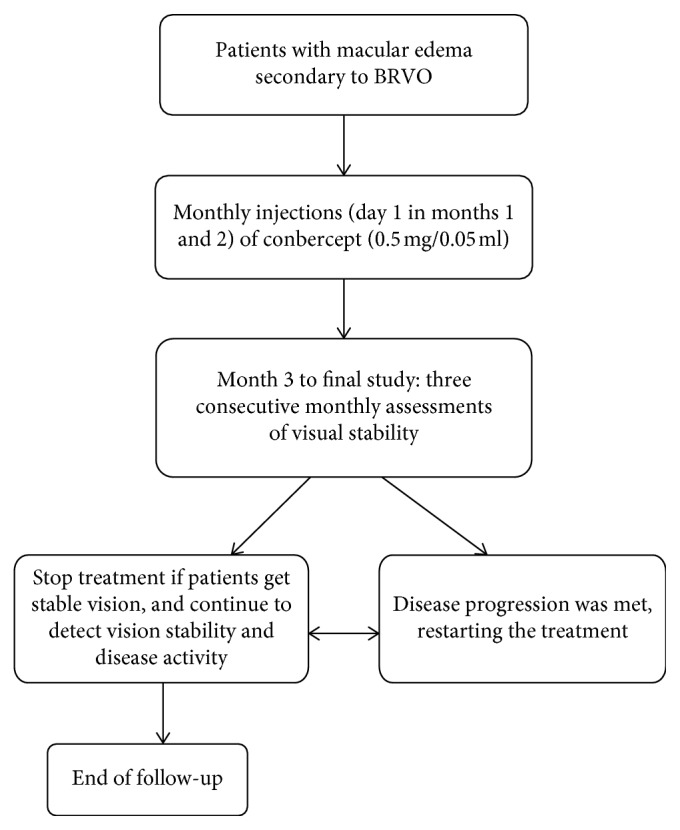
Study flow chart.